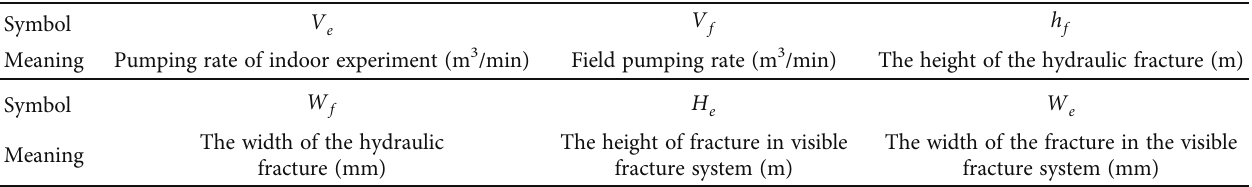
Table 3: Meaning of the symbols in Equation